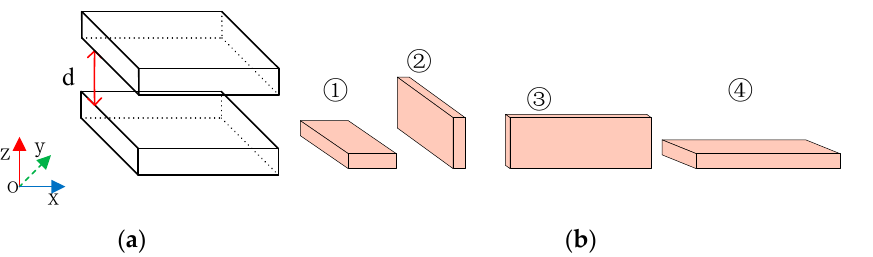
Figure 12. ( a ) A situation where two components are distributed vertically; ( b ) Different ways of spreading through the bus between two components distributed vertically.